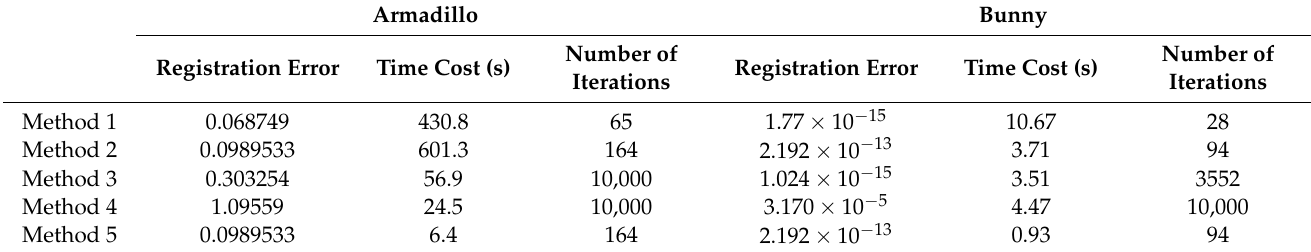
Table 4. Performance comparison.